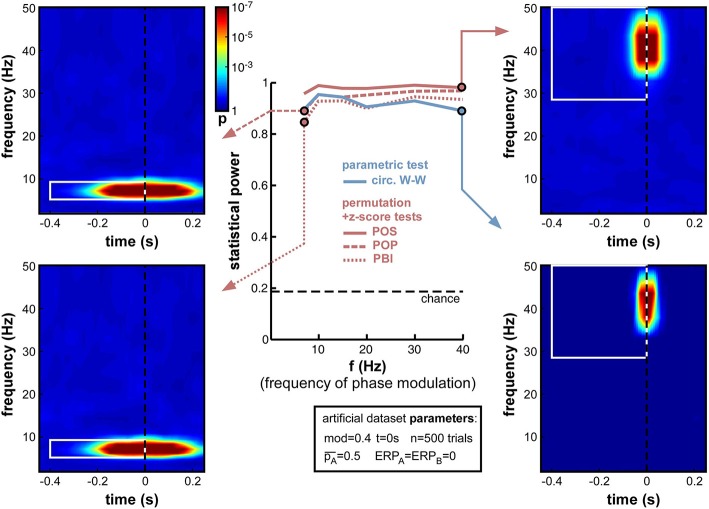
Effect of varying frequency of oscillatory phase modulation (in the absence of an ERP). For improved readability, only the parametric circ. W-W test and the hybrid permutation + z-score tests are presented in this and all subsequent figures. Each conventional permutation test (not shown) consistently mirrors the patterns of the corresponding hybrid test, only with marginally lower statistical power. All tests appear relatively robust to changes in oscillatory frequency.